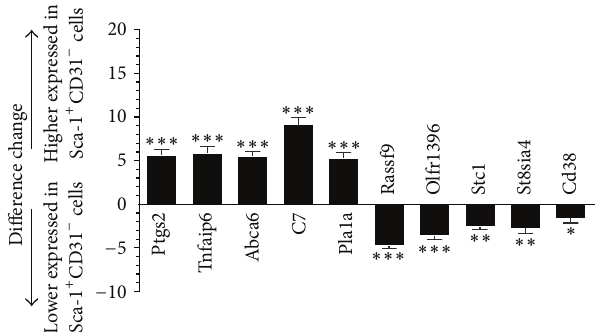
Figure 5: Expression profiles of genes detected by dd-PCR. Bars: difference changes in expression in Sca-1 + CD31 − cells versus Sca- 1 + CD31 + cells. Expression was normalized to GAPDH and the expression change was calculated based on a mean of three biolog- ical replicates. Bars above and below the 𝑥 -axis show upregulated and downregulated genes in Sca-1 + CD31 − cells. Differences were analyzed with Student’s 𝑡 -test. ∗ 𝑃 < 0.05 , ∗∗ 𝑃 < 0.01 , and ∗∗∗ 𝑃 < 0.001